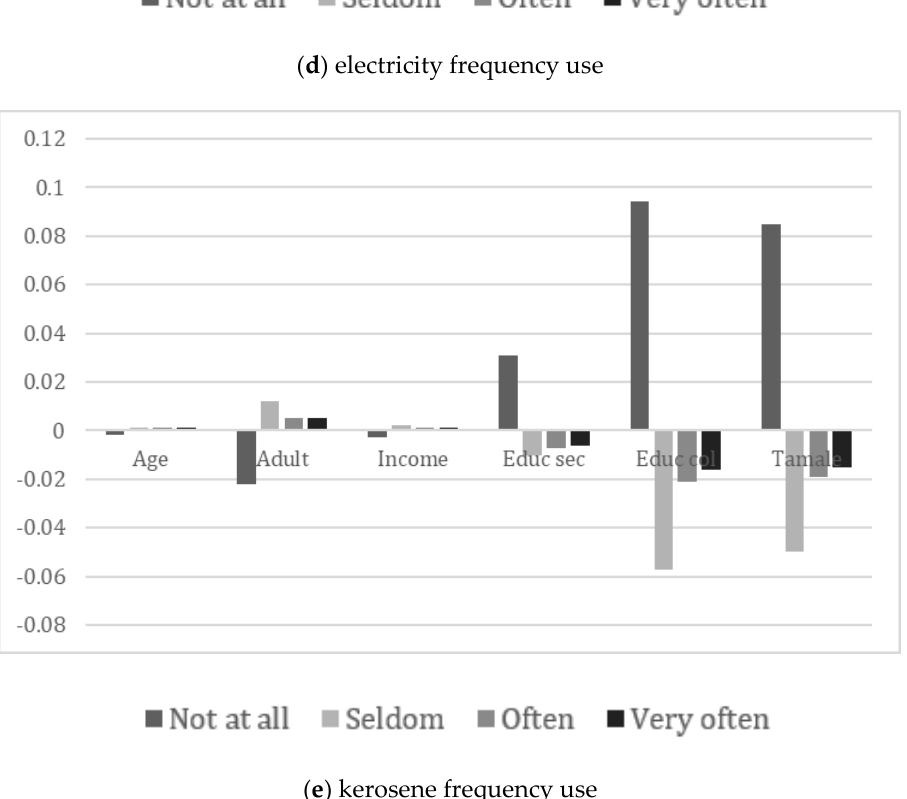
Figure 2. Marginal effects of statistically significant factors on the probability of wood ( a ), charcoal ( b ), liquid gas ( c ), electricity ( d ), and kerosene ( e ) use frequency to cook the main meal of the day in urban households of Ghana. Note: n = 956; full definitions of variables in Table 1. Source: Calculations based on the estimation results shown in Table 3.